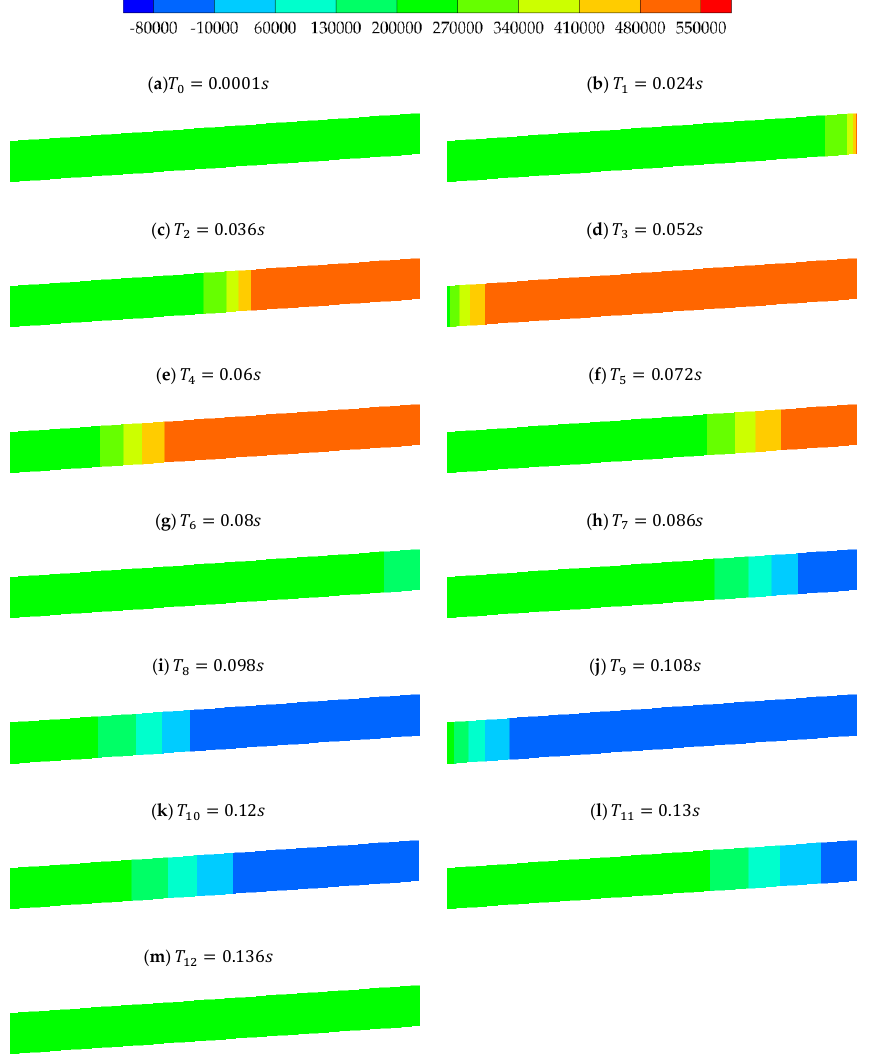
Figure 7. Pressure field evolution during the first wave cycle on the axis plane of the pipeline.